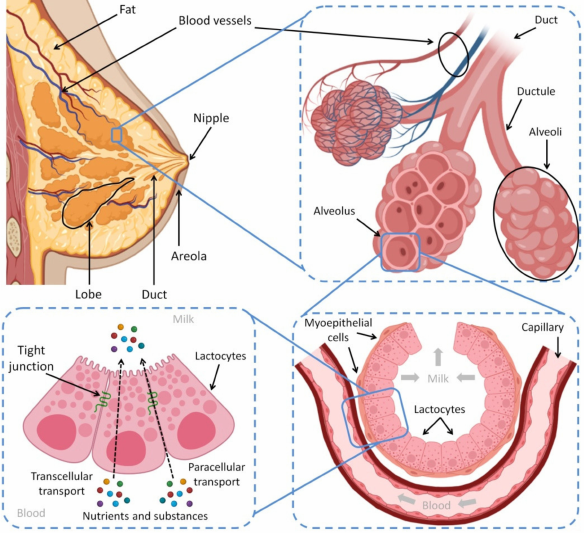
Figure 1. A cross-section scheme of the mammary gland, breast lobe components and process of lactation. Lactation is the process of producing milk from mammary glands in response to